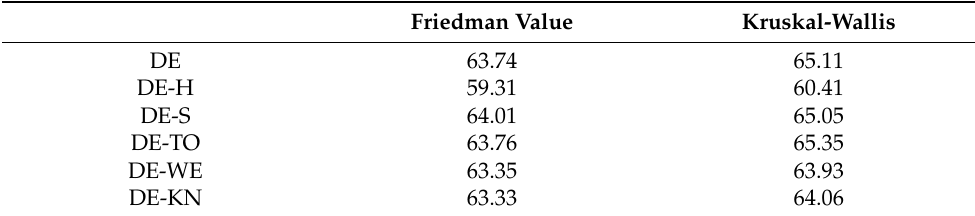
Table 7. Mean ranks obtained by Kruskal–Wallis and Friedman test for all DE-based approaches.